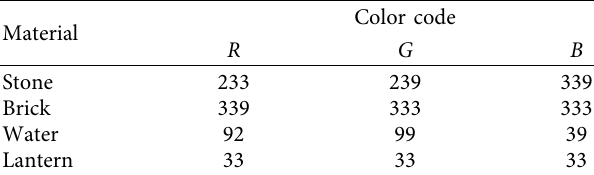
Table 2: Scenarios with different wood